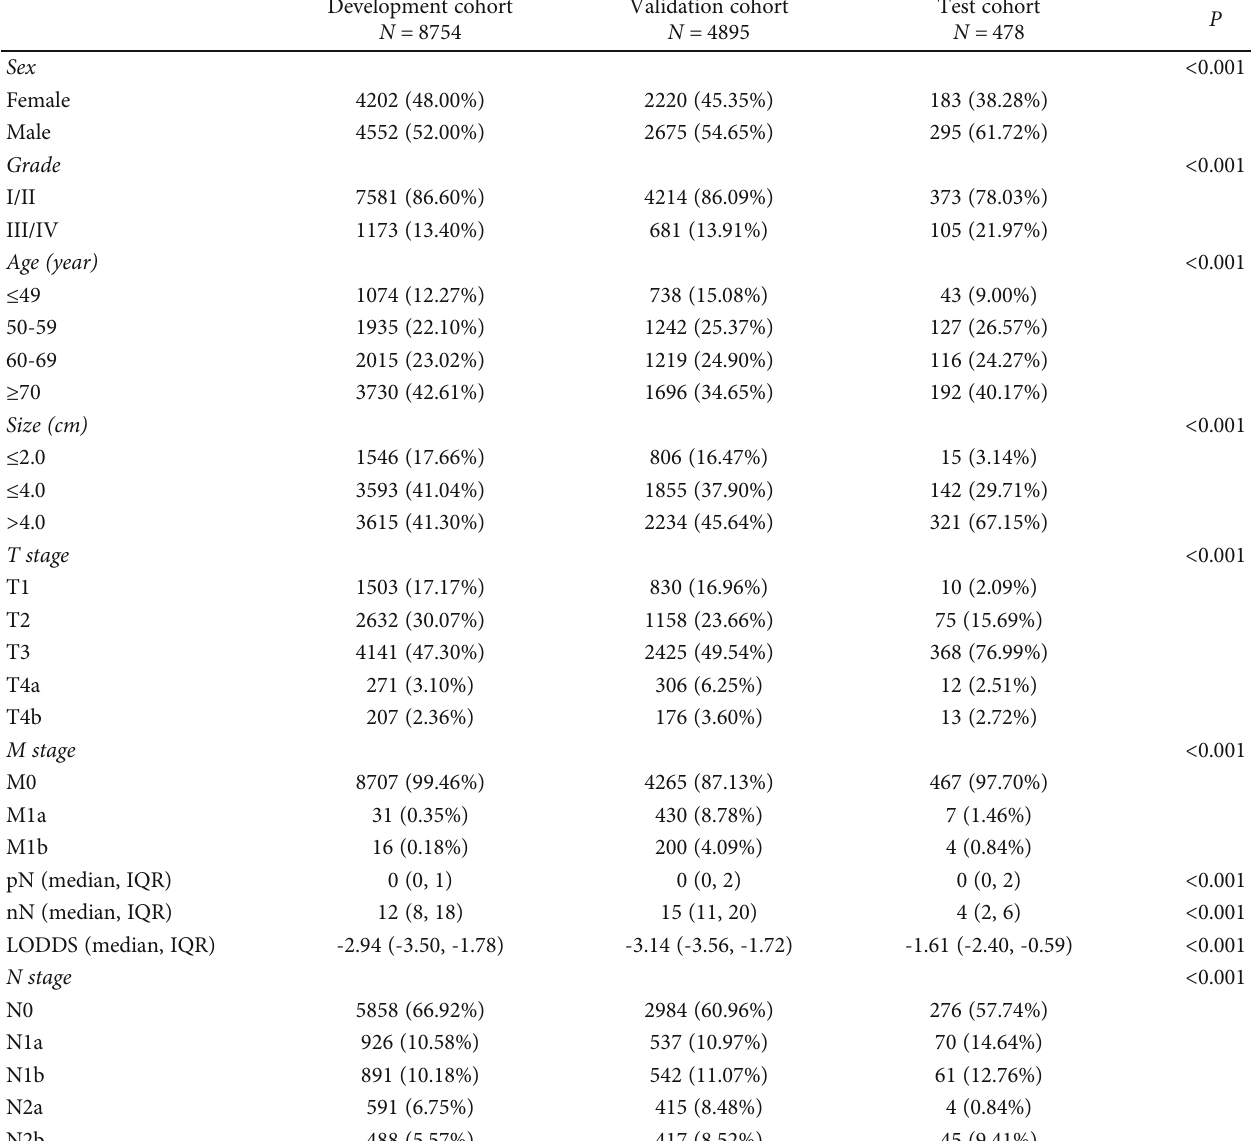
Table 1: Clinical characteristics of patients with rectal cancer in di ff erent